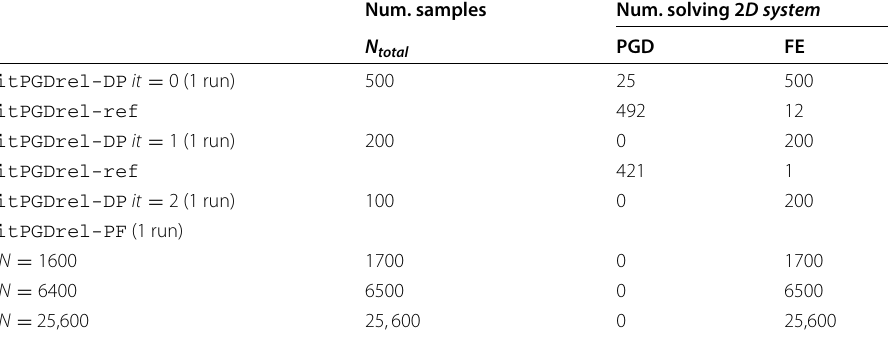
Table 7 Cross-section: comparison of the number of required solutions of the 2 D equation system to compute u (FE) or F 1 (PGD) in the itPGDrel analysis ( N total total number of samples) Num. samples Num. solving 2 D system N total